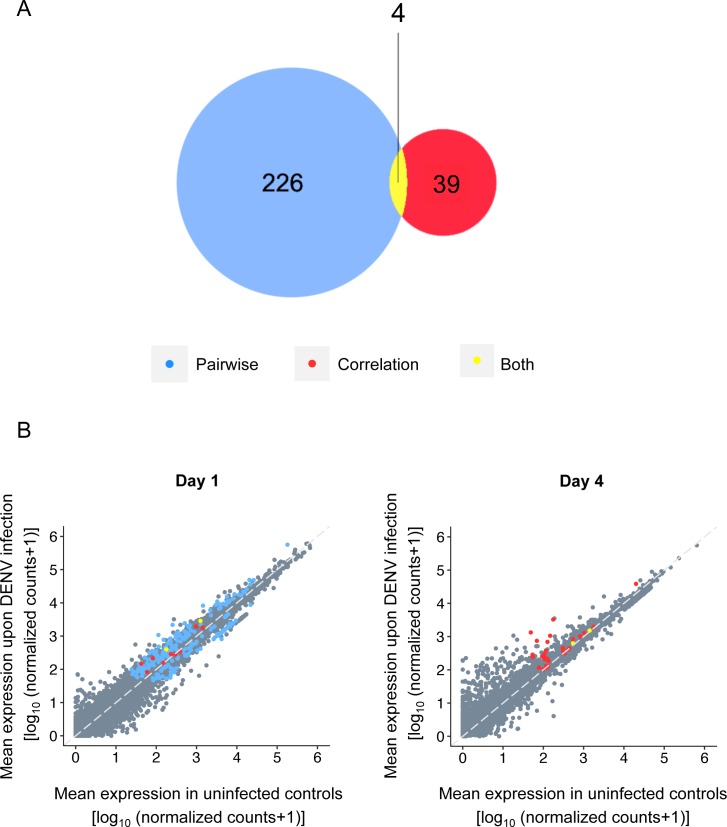
Candidate host factors identified by pairwise comparison and correlation analysis of transcriptome-wide midgut gene expression.(A) Venn diagram showing the number of candidate genes differentially expressed between DENV-infected midguts and uninfected controls (blue) or whose expression was linearly correlated to midgut viral RNA load (red) at a false discovery rate of 0.1, across time points. Common candidate genes between pairwise and correlation analyses are shown (yellow). (B) Time-specific representation of DENV-infected midgut transcriptome plotted against control midgut transcriptome (log10 [normalized RNA-Seq counts +1]) at day 1 and day 4 post exposure. Candidate transcripts identified by pairwise comparison (blue), correlation analysis (red) or both (yellow) are indicated.